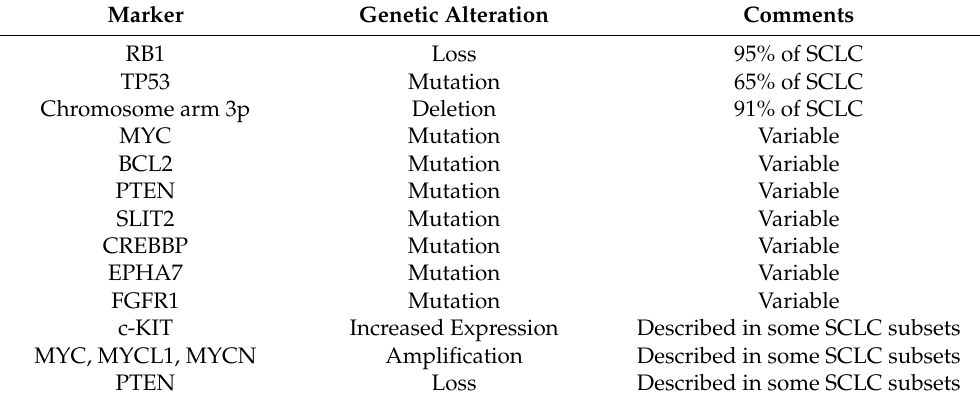
Table 2. Genomic alterations and markers for Small cell lung carcinoma